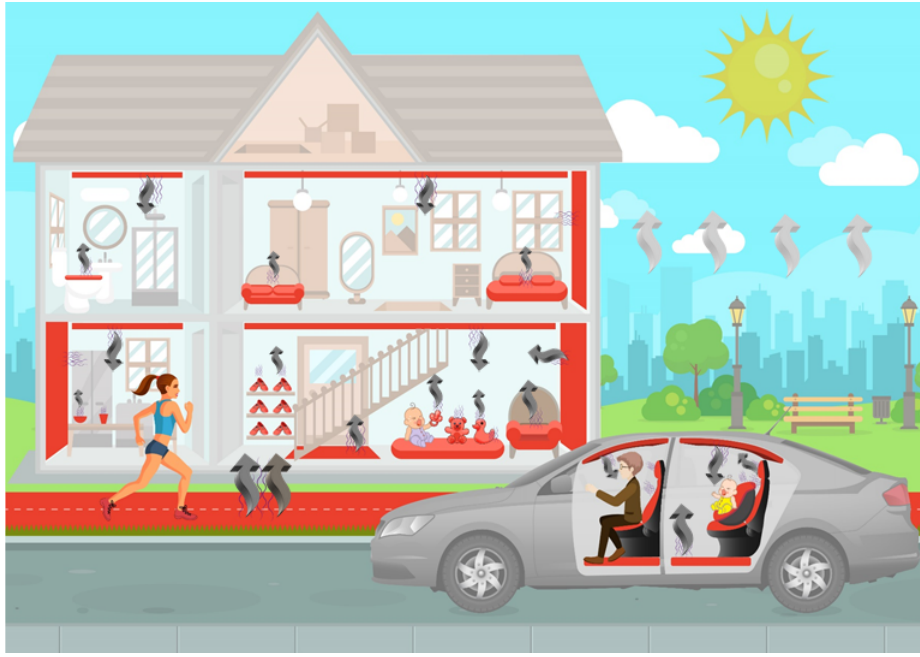
Figure 1. Illustration of the polymer foams usage and the time-releasing gases from the foams in the living